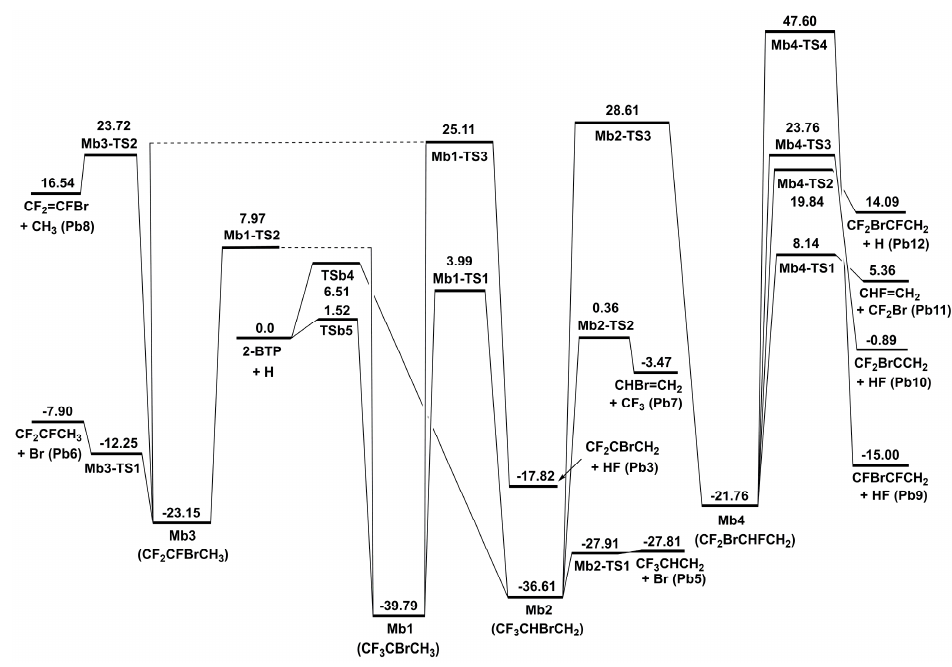
Figure 6. Schematic energy diagram of addition and eliminations for 2-BTP + H at 0 K in kcal/mol at CCSD(T)/aug-cc-pVTZ//B3LYP/aug-cc-pVTZ (zero-point vibrational energy included). CCSD(T)/aug-cc-pVTZ//B3LYP/aug-cc-pVTZ (zero-point vibrational energy